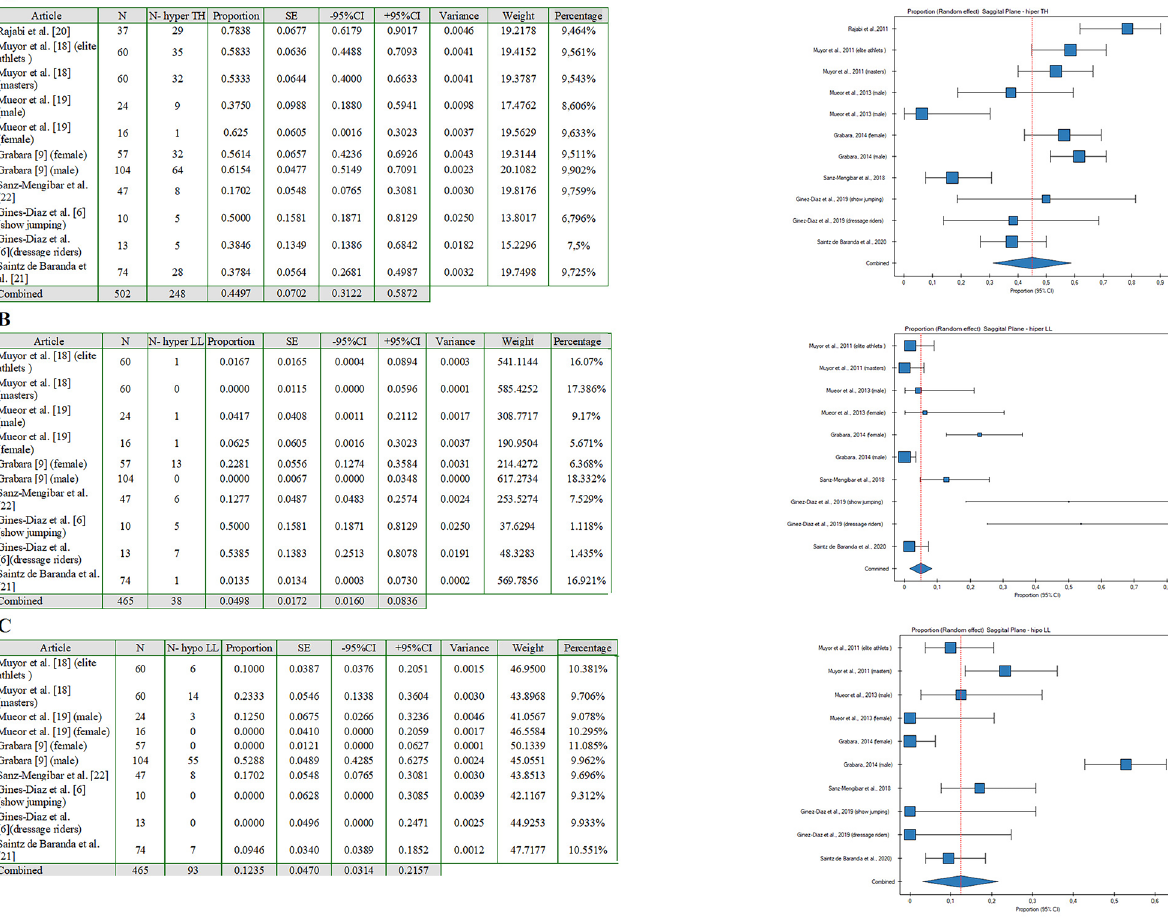
Figure 2. Forest plot (random-effects model) showing the incidence of ( A ) hyper TH, ( B ) hyper LL, ( C ) hypo LL in the sagittal plane for each of the included studies and the pooled incidence for all studies (created with: PQStat software (version PQStat V